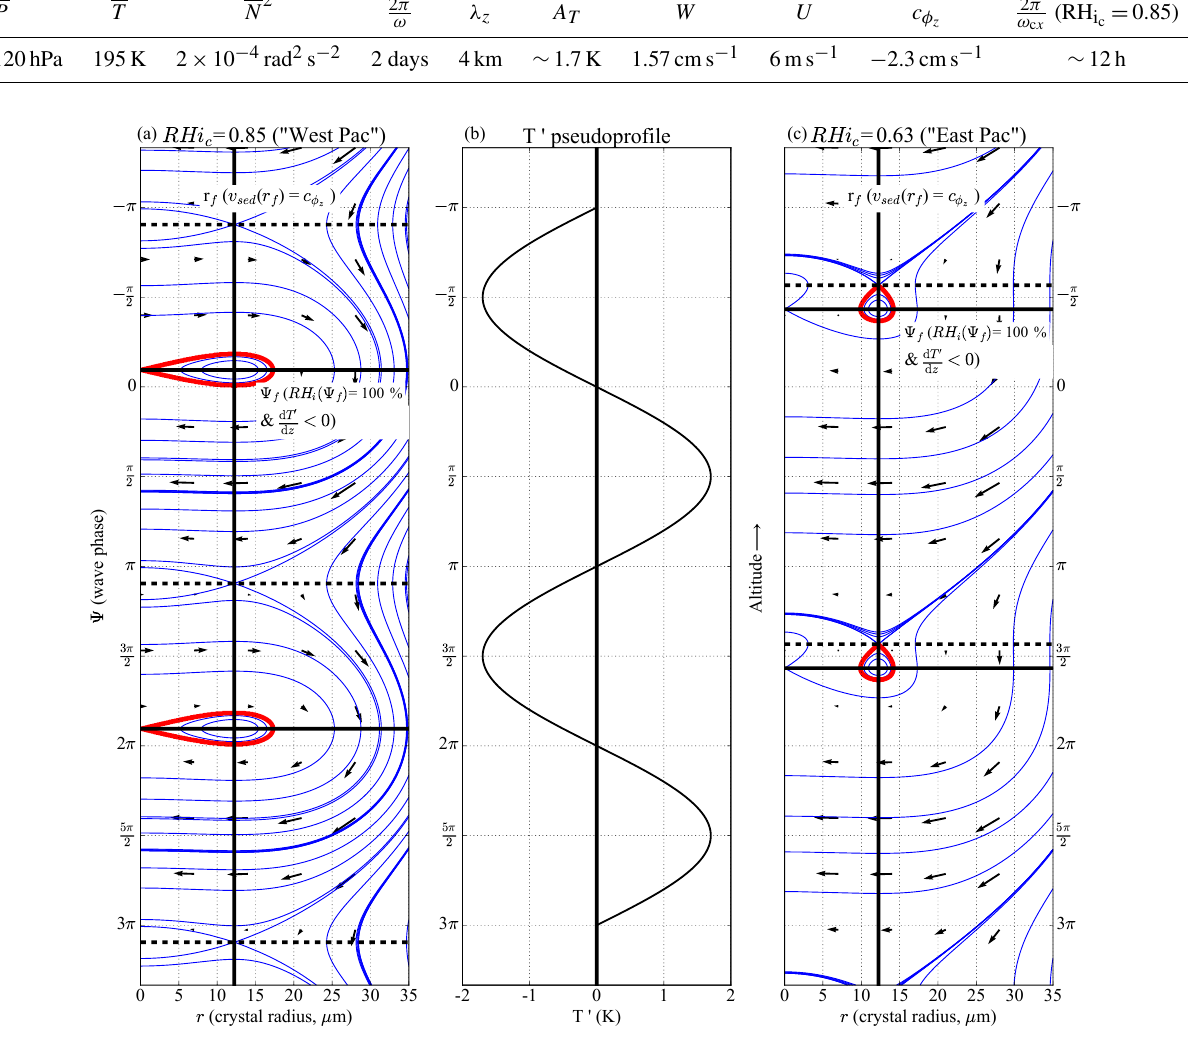
Figure 2. Panels (a) and (c) : representation in the (cid:57) – r phase space (phase portrait) of ice crystals’ trajectories (blue lines) obtained with = 0.85, wave parameters given in Table 1 for two different background relative humidities: a moist case similar to the western Pacific (RH i c = 0.63, c ). These trajectories correspond to constant values of the Hamiltonian function a ) and a drier case similar to the eastern Pacific (RH i c (Eq. 30). Black arrows along the blue lines indicate the trajectory direction. The vertical heavy line corresponds to r f , the particle radius at the fixed points. The heavy horizontal black lines show the location of the wave phase of the elliptic (solid) and saddle (dashed) fixed points. The heavy red lines limit the area around the elliptic fixed point where the crystals have “perpetual” periodic trajectories. It should be noted that the y axis ( (cid:57) ) is similar to a vertical profile, with decreasing (cid:57) corresponding to increasing altitude (since m< 0); the corresponding temperature anomaly profile due to the wave is sketched on (b)